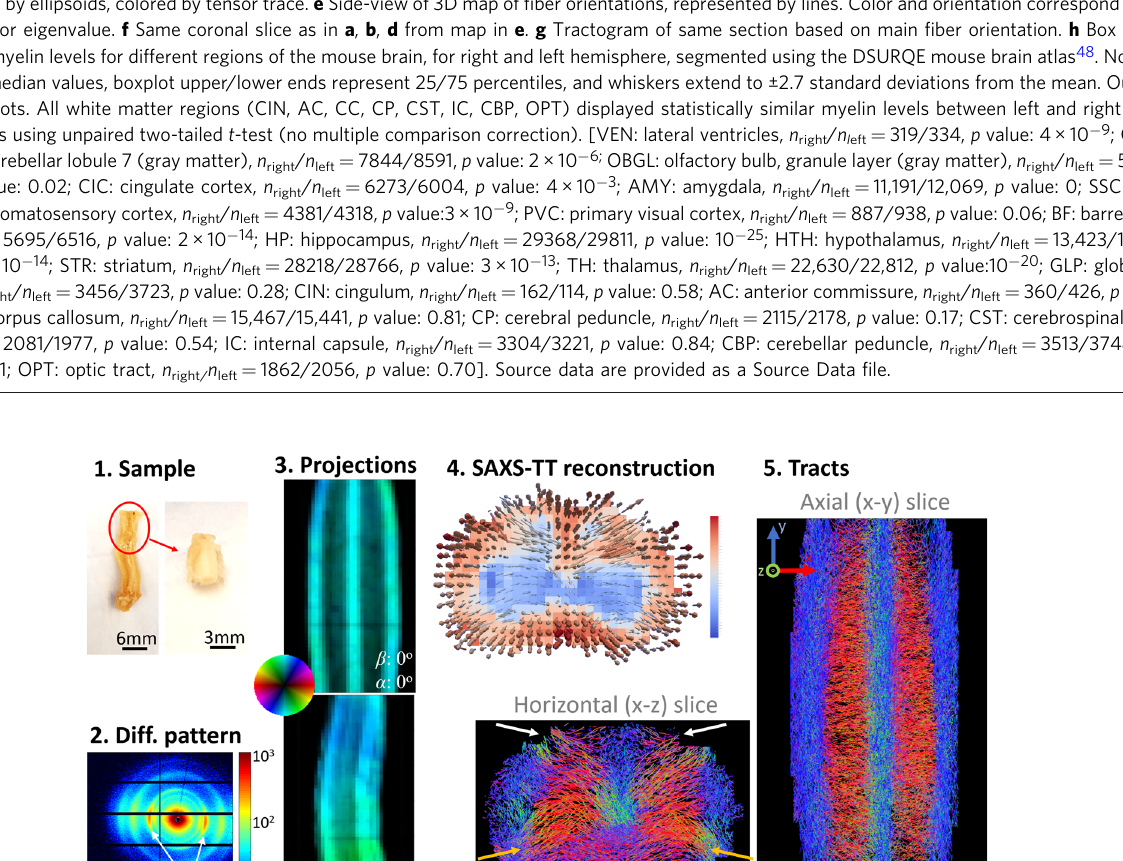
Fig. 3 SAXS-TT on mouse spinal cord. 1 The cervical part of the fi xed spinal cord was scanned and 2 produced strong myelin peaks in the diffraction patterns (white arrows). 3 Each 2D scan resulted in a projection depicting SAXS myelin peak intensity and 2D orientation of the myelinated axons. 4 Tensor-tomographic reconstruction of all projections provided 3D fi ber orientations per voxel, here visualized by a vector map for a virtual section. Vectors are colored based on myelin levels in the corresponding voxel. 5 A probabilistic tractography algorithm enabled generating neuronal tracts for the specimen, an axial and a horizontal section of which are shown. Arrows point to anterior (orange) and posterior (white) thick histological sections covering the same brain ’ s left hemi- metrics with SAXS-TT (Fig. 5a, rows 2 and 4) yielded almost sphere (Fig. 5a). Histology and SAXS-TT results were also com- identical coef fi cients as with histology (Fig. 5a, rows 1 and 3), pared with MRI data of the same brain (Fig. 5a and further supported by the high linear correlations between the Supplementary Fig. 4) using a variety of myelin-sensitive contrasts coef fi cients of MRI metrics against both SAXS-TT and histology based on (i) magnetization transfer — MT 27 : MT ratio (MTR) and (Fig. 5b, c), with r = ~1 and the regression lines almost on the MT saturation (MT sat ), (ii) relaxometry: T 1 and T 2 relaxation identity line. This suggests SAXS-TT ’ s potential as the reference times, and (iii) dMRI, including diffusion tensor/kurtosis 28 ima- myelin imaging method, with the additional bene fi ts of no extra sample preparation, its nanostructural speci fi city, and its non- destructive nature. SAXS-TT-derived axon orientations for a mouse brain (Fig. 2) and a mouse spinal cord (Fig. 3) were compared to those obtained on the same samples from ex vivo diffusion MRI (Fig. 5d – i). The main axon orientations from the two methods are shown in co- registered datasets (Fig. 5d, e, g, h). Co-linearity between orientations from the two methods for all brain voxels is assessed by the dot product of their unit vectors (Fig. 5f, i). For both samples, the dot product distribution is heavily skewed towards 1, indicating that orientations are in good agreement, consistent with previous comparisons between X-ray scattering- and dMRI- derived orientations on thin mouse brain vibratome sections 14 .